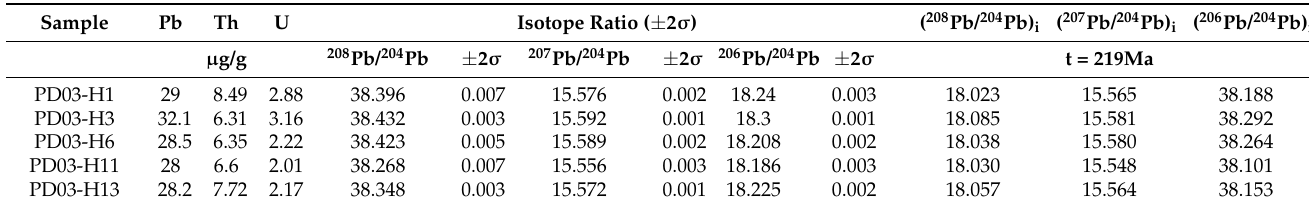
Table 5. Pb isotopic composition of the Wuzhutang granite in the Xuebaoding mining area.